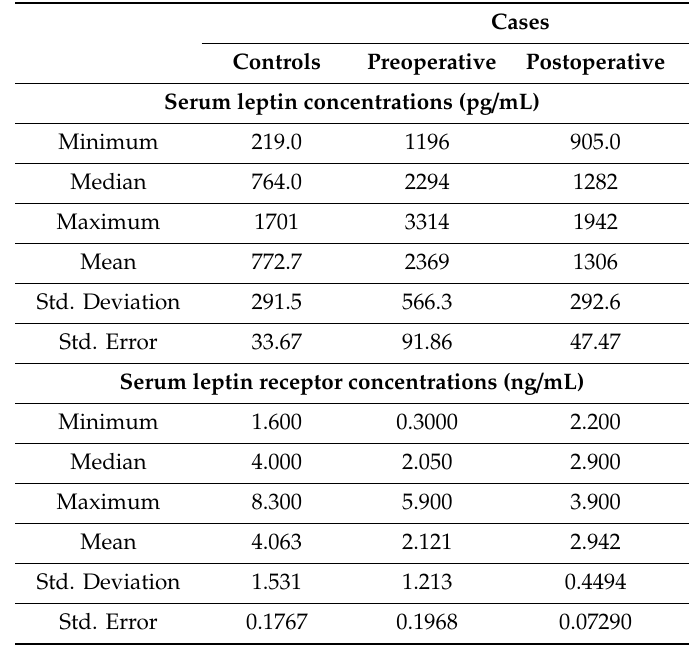
Table 2. Summary descriptive statistics of measured serum leptin and leptin receptor in all subjects.